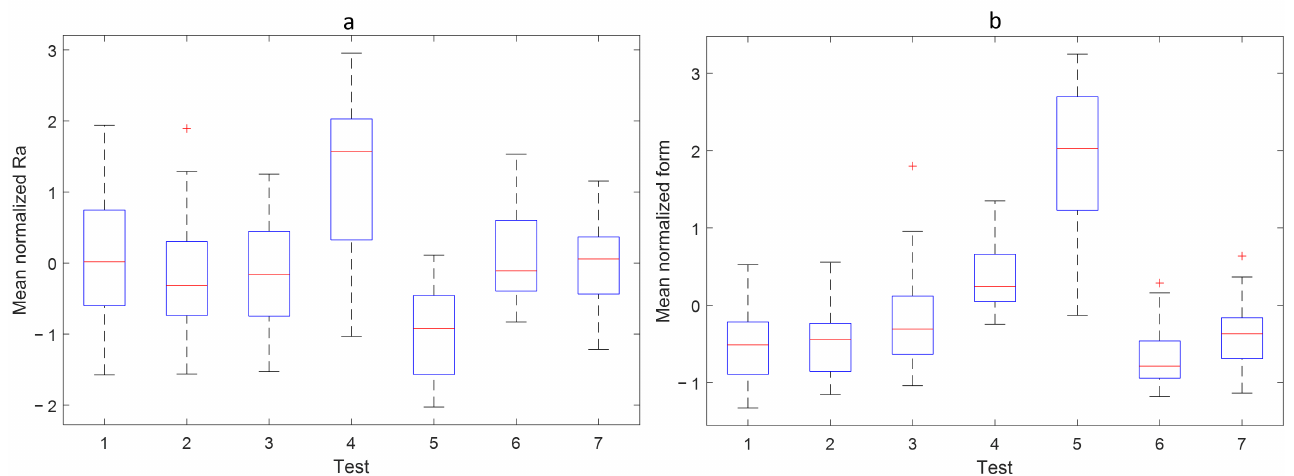
Figure 8. Box plot of ( a ) Mean Normalized Surface Roughness and ( b ) circumferential form mea- surement. The box plot for each test 1–7 includes measured rings from all the dress cycles. The red + indicate outlier value that is more than 1.5 times interquartile range away from bottom or top of the